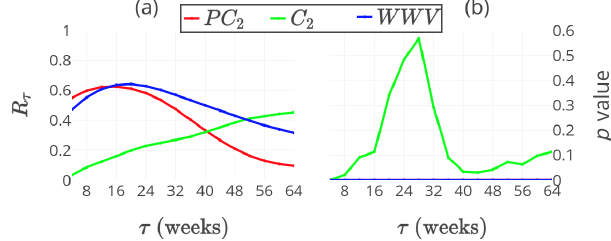
Figure 5. (a) The cross-correlation of the PC 2 , WWV and c 2 with respect to NINO3.4 for different lags τ . (b) The p value of the Wiener–Granger hypothesis test for the same lags. A low p value implies the variable is likely to cause the NINO3.4 index at the spe- cific lag due to Granger causality. The p values of the PC 2 and WWV are almost zero for all lags.